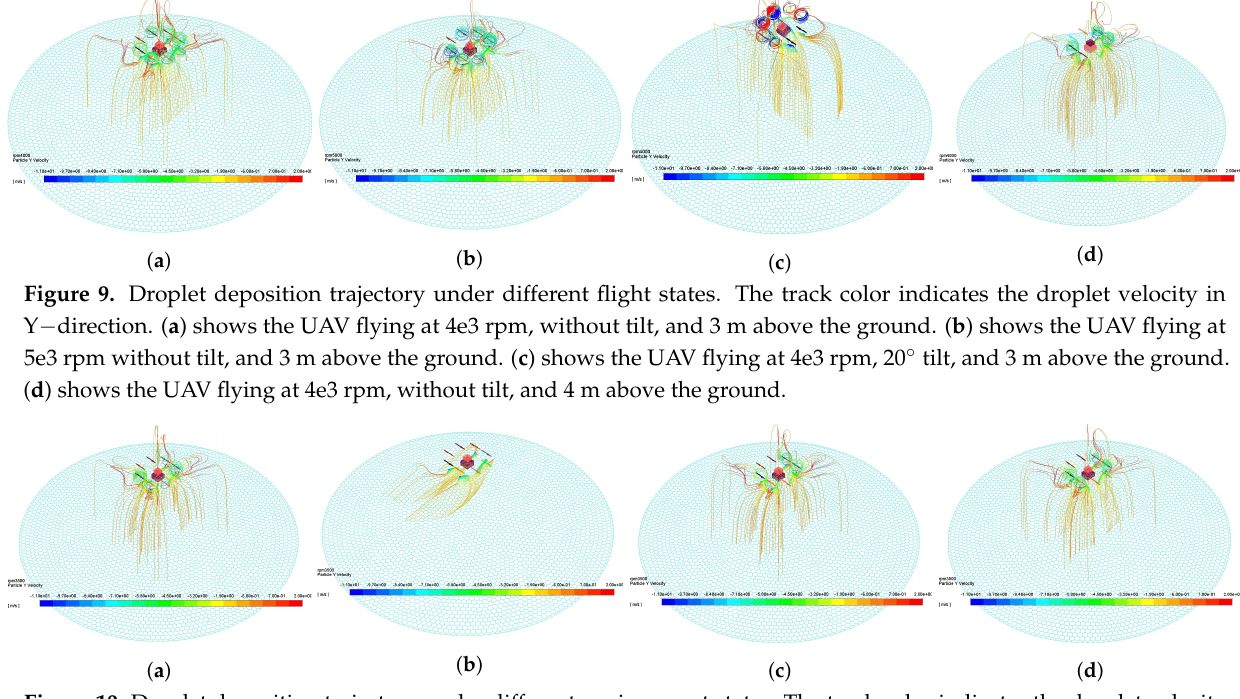
Figure 10. Droplet deposition trajectory under different environment states. The track color indicates the droplet velocity in Y − direction. ( a ) shows the environment state of 0 m/s wind velocity, 10 ◦ C temperature, and 50% relative humidity. ( b ) shows the environment state of 1 m/s wind velocity, 10 ◦ C temperature, and 50% relative humidity. ( c ) shows the environment state of 0 m/s wind velocity, 40 ◦ C temperature, and 50% relative humidity. ( d ) shows the environment state of 0 m/s wind velocity, 10 ◦ C temperature, and 100% relative